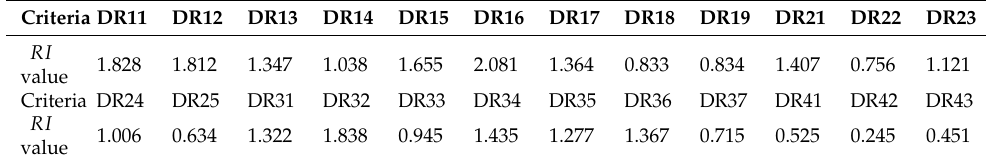
Table 11. Relative importance RI of